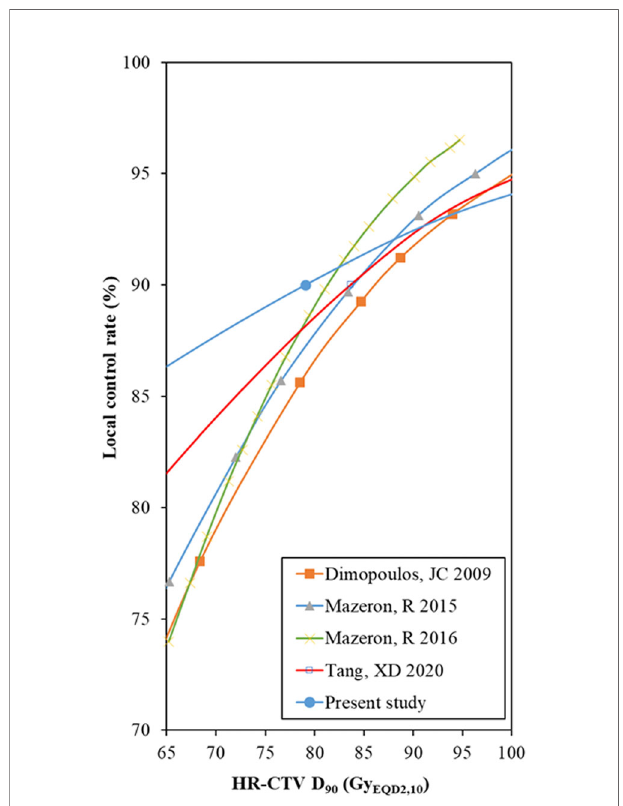
FIGURE 4 | Comparison of the probit model results between the HR-CTV D90 and local control rate. HR-CTV = high-risk clinical target volume, D90 = the minimum dose delivered to 90% (of the target volume). *The data points of the probit models were manually extracted from the published fi